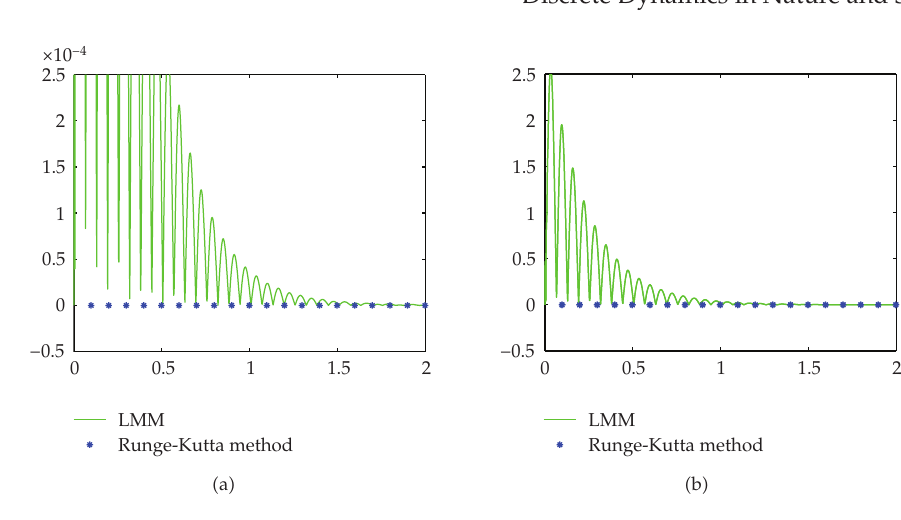
Figure 5: Errors of Runge-Kutta method and LMM (cid:3) 4.28 (cid:4) with h (cid:5) 0 .